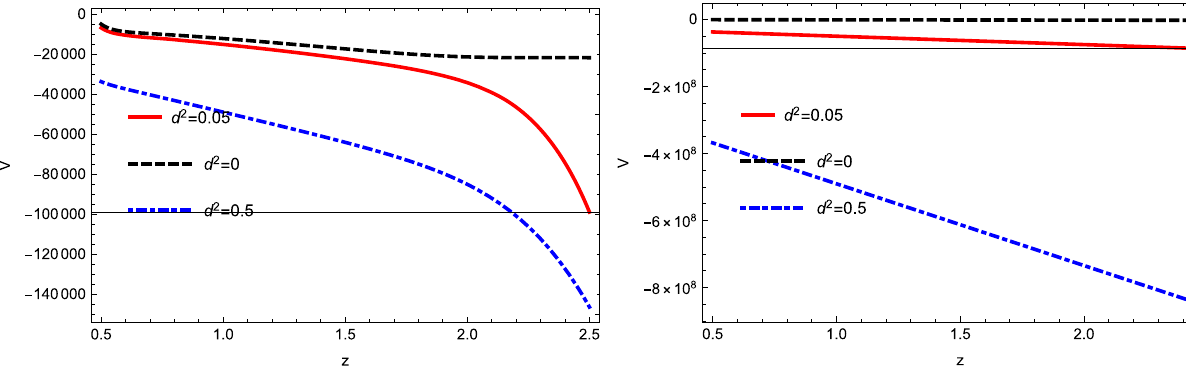
Fig. 38 Plot of V verses z for u = 1 and u = 2 . 002 for tachyon scalar field model